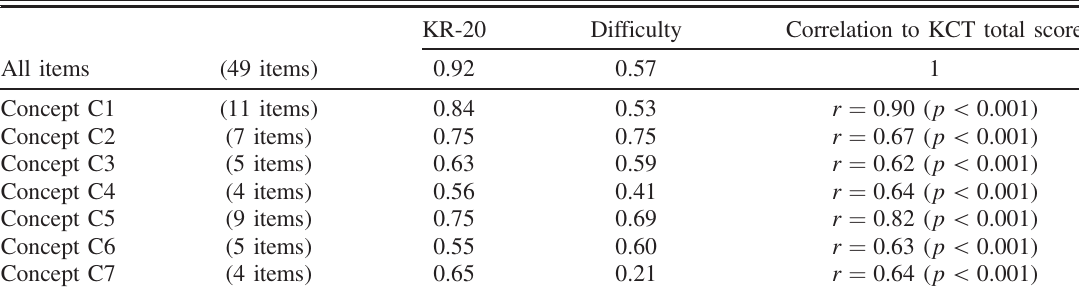
TABLE VI. Reliability (KR-20) values and difficulties for the items grouped according to their associated concepts, calculated from a data set of 338 Gymnasium students. The last column shows the correlation of the concept scores to the total test scores. The four items (7, 19, 23, 37) which can be associated to two concepts are only considered in the total score (as they were also skipped in the factor analysis). Adding these items to the corresponding concepts would slightly increase the KR-20 and, obviously, the correlation values. The difficulty values would remain at the same levels ( (cid:3) 0 . 03